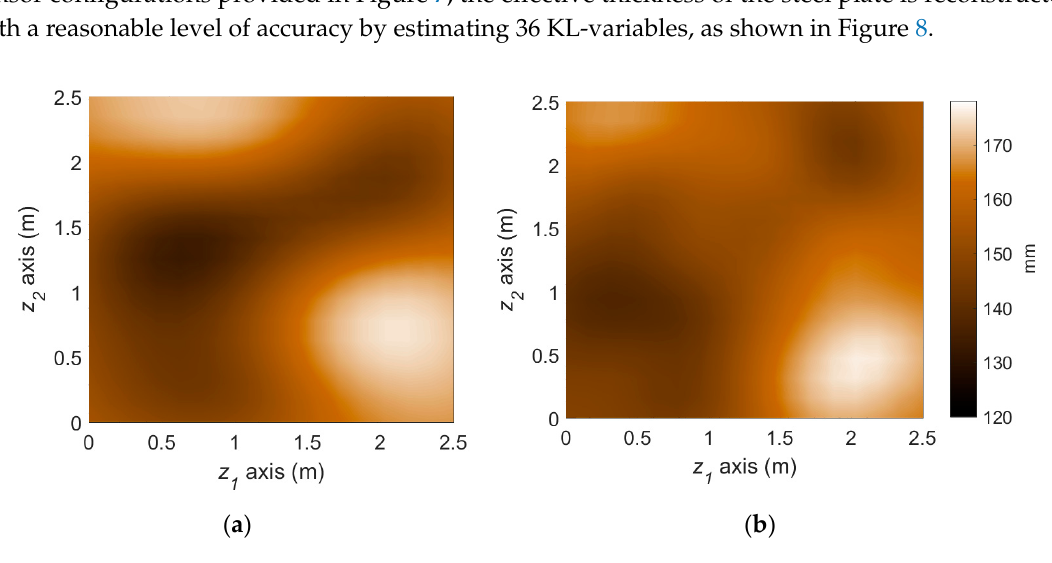
Figure 8. Deterioration state (effective thickness, mm) at year 22 from the reference scenario and Bayesian inversion method: ( a ) Reference deterioration scenario; ( b ) Inferred deterioration pattern